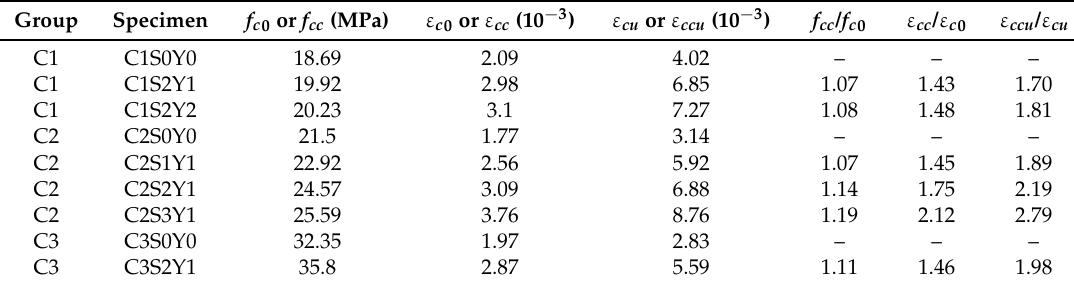
Table 5. Test results.